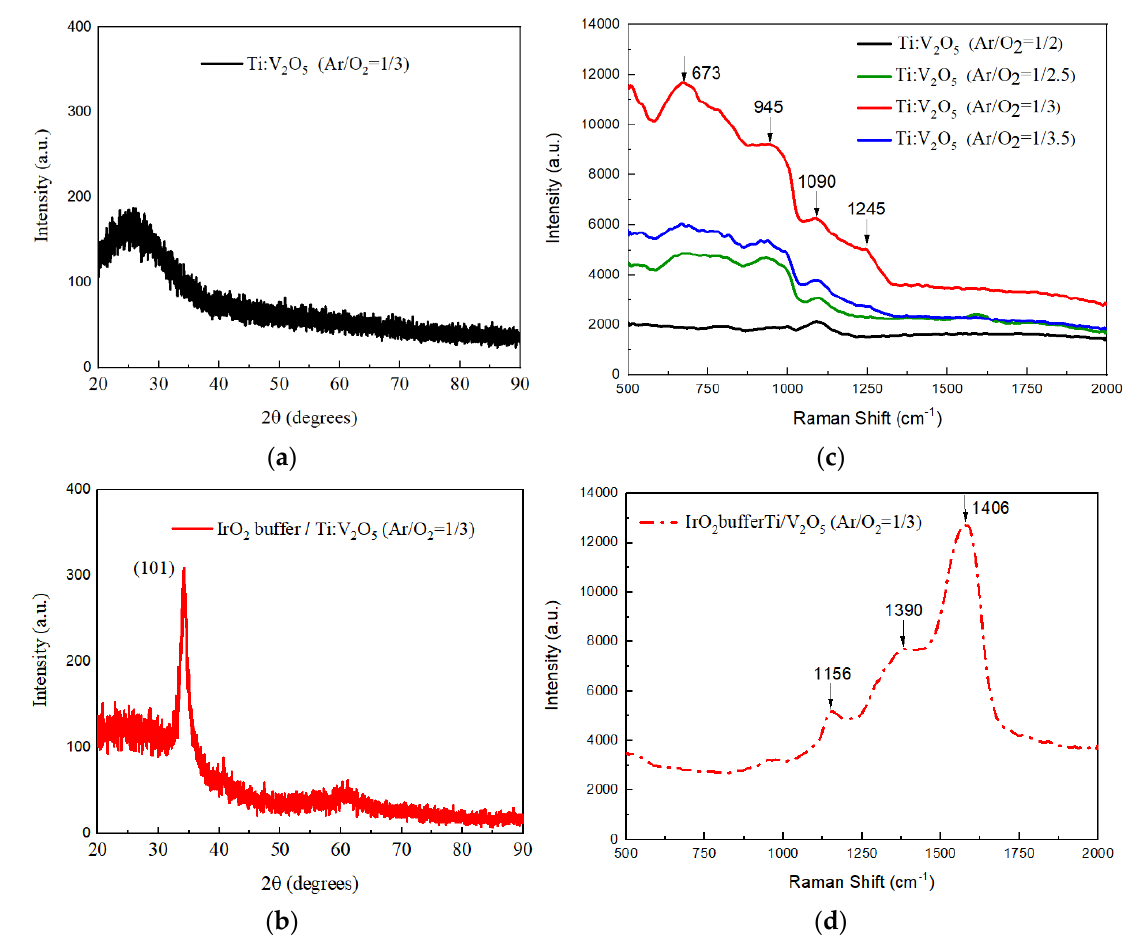
Figure 8. ( a ) and ( b ) X-ray diffraction of Ti:V 2 O 5 films and IrO 2 buffer/Ti:V 2 O 5 films at an Ar/O 2 ratio of 1/3; ( c ) and ( d ) Raman spectroscopy of Ti:V 2 O 5 films with various Ar/O 2 ratios and IrO 2 buffer/Ti:V 2 O 5 at an Ar/O 2 ratio of 1/3.